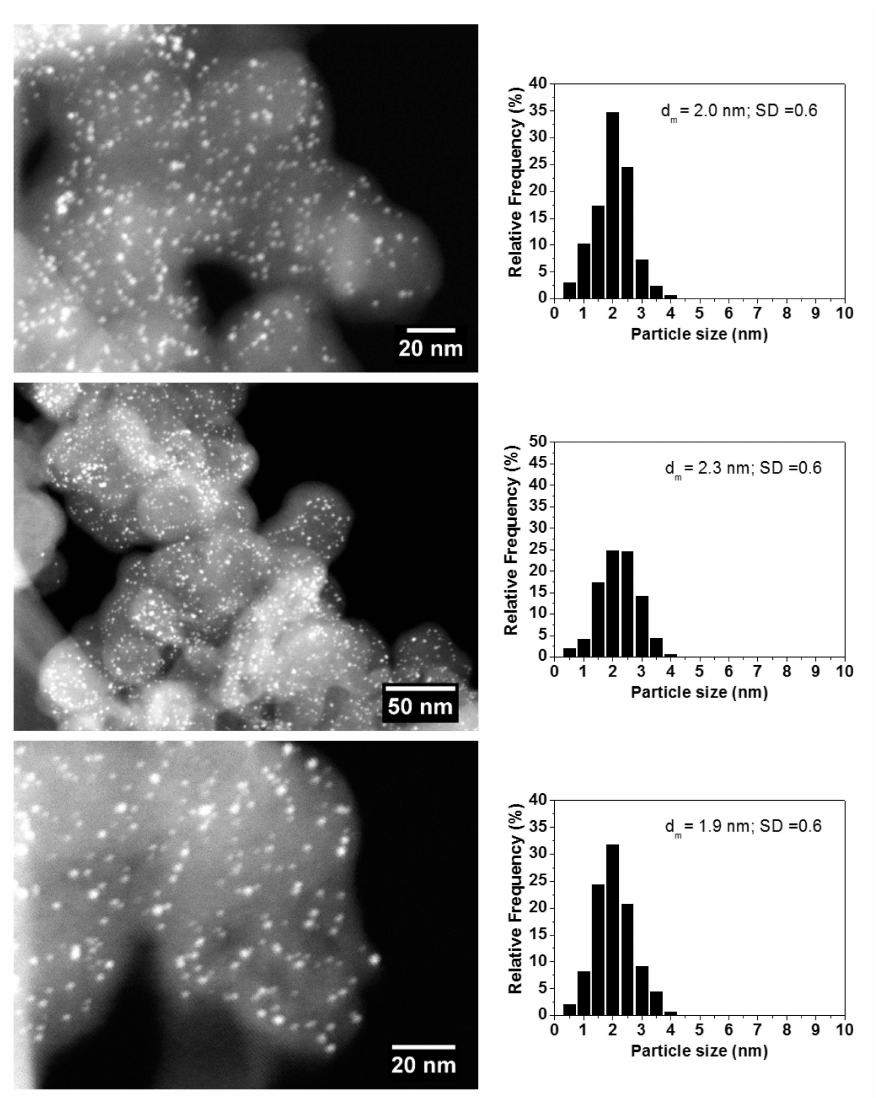
Figure 7. Representative HAADF-STEM micrograph and particle size distribution of Au 4 Cu 1 / C (top), Au 1 Cu 1 / C (middle), Au 1 Cu 4 / C